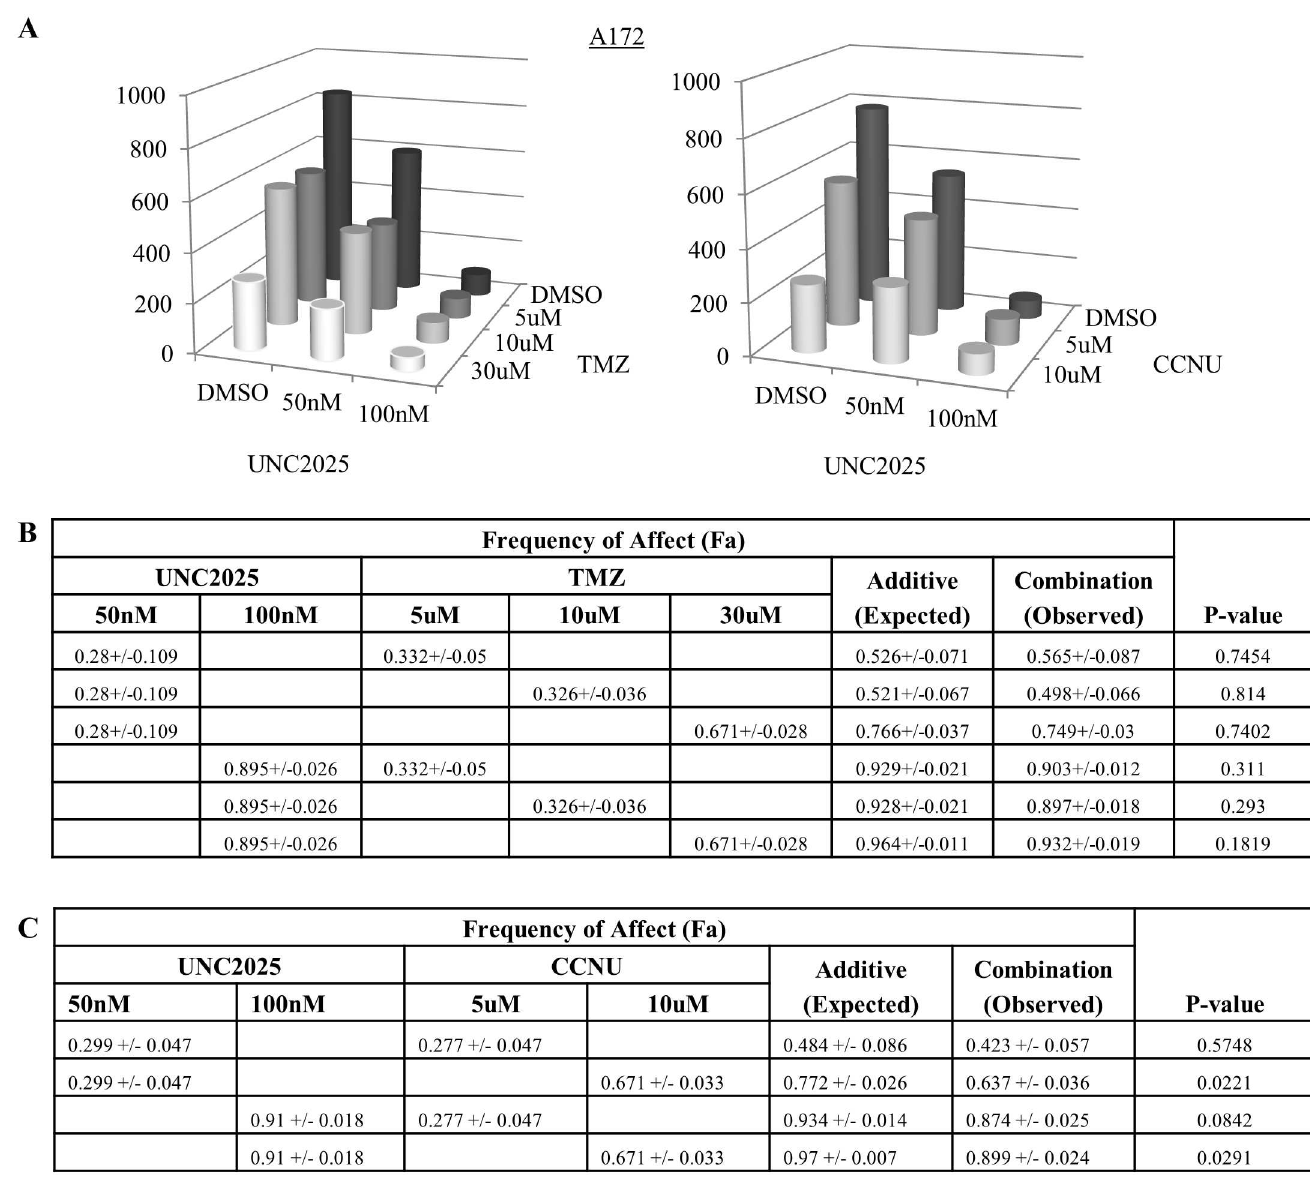
Fig 7. Treatment with UNC2025 in combination with standard GBM chemotherapy is more effective than single agents. A172 cells were incubated for 9 days with UNC2025or vehicle (DMSO) combinedwith either lomustine(CCNU) or temozolomide (TMZ). Colonies were fixed and stained with crystal violet in 25% methanol and then counted. (A) Mean values derived from four independent experiments. (B-C) The expected frequency of affect (Fa) for an additive interaction was determined using the Bliss additivity model [32] and is shown (Additive). Statistically significant (p value < 0.05, student’s paired t test) increasesin the observed Fa mediated by UNC2025 plus chemotherapy (Combination) relative to the values expectedfor an additive interaction were not observed, indicatingadditive interactions. (B) Analysis of interactions between UNC2025 and TMZ. (C) Analysis of interactions between UNC2025and